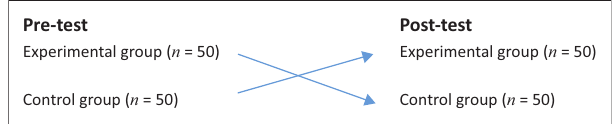
FIGURE 1: A counterbalanced within-subject single-factor experimental